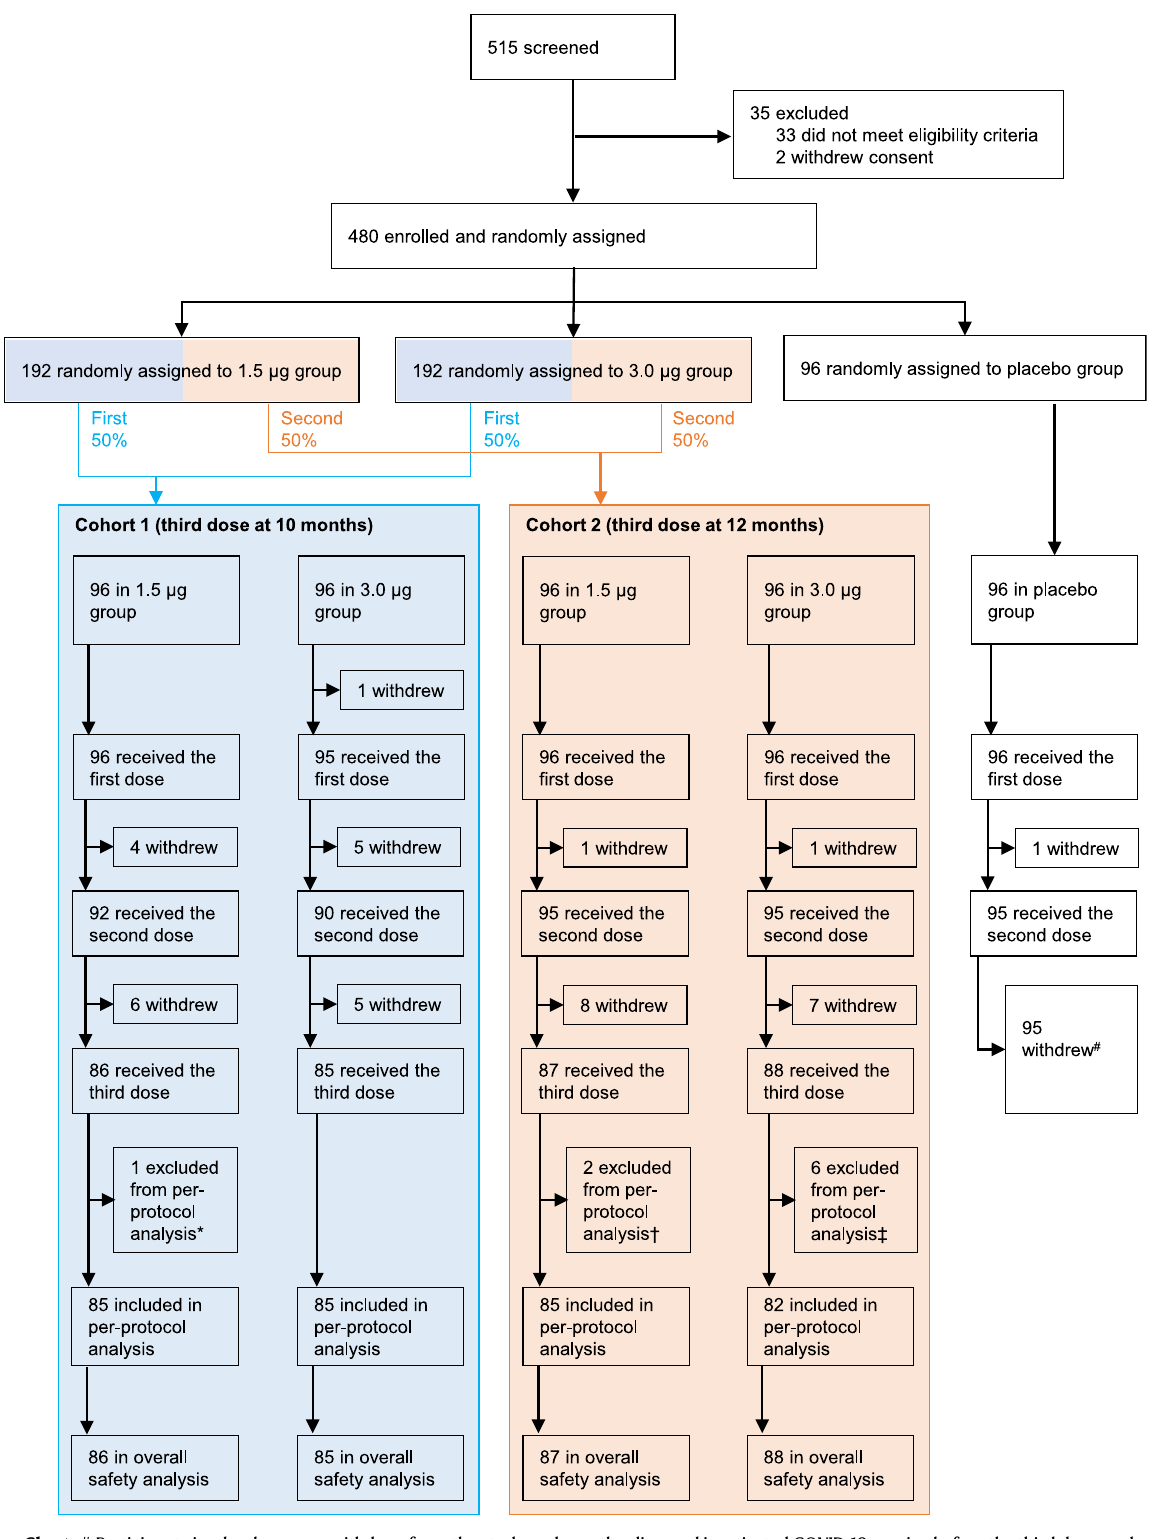
otherlicensedinactivatedCOVID-19vaccinebeforethethirddose,andonedidnot have a blood sample taken 28 days after the third dose. ‡ Participants in the 3.0 μ g group were excluded from the per-protocol analysis because they received other licensedinactivatedCOVID-19vaccinebeforethethirddose,and fi vedidnothavea blood sample taken 28 days after the third